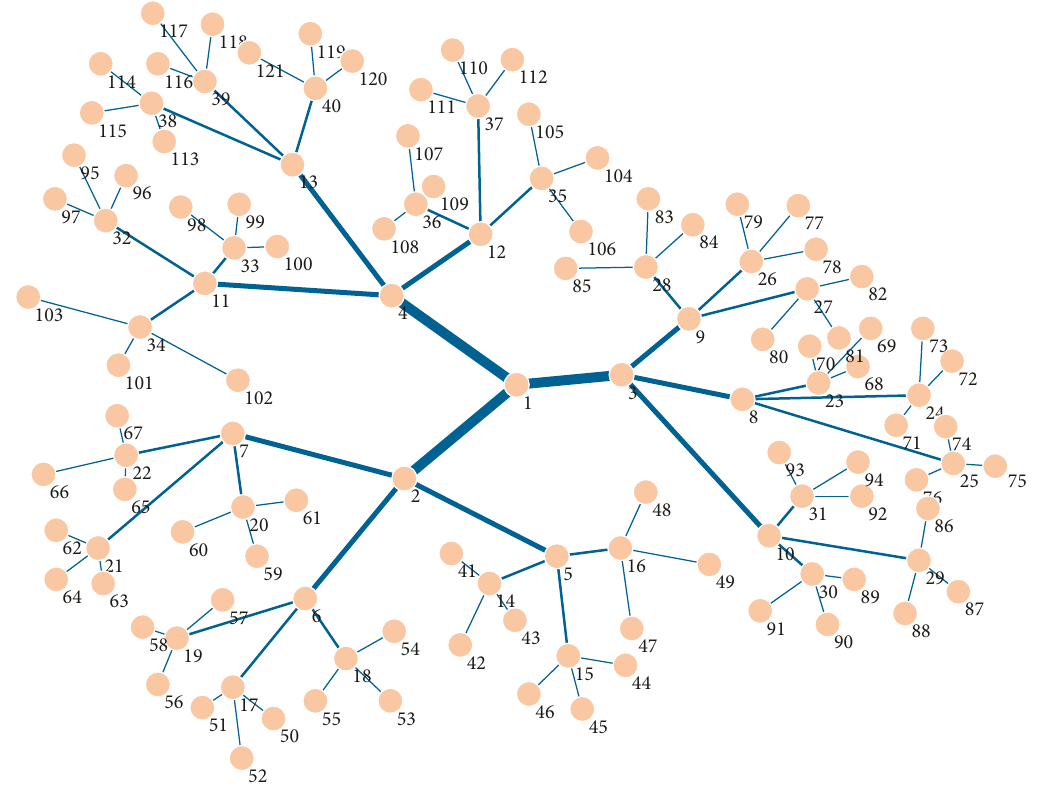
Figure 2: A constructed SFnet.